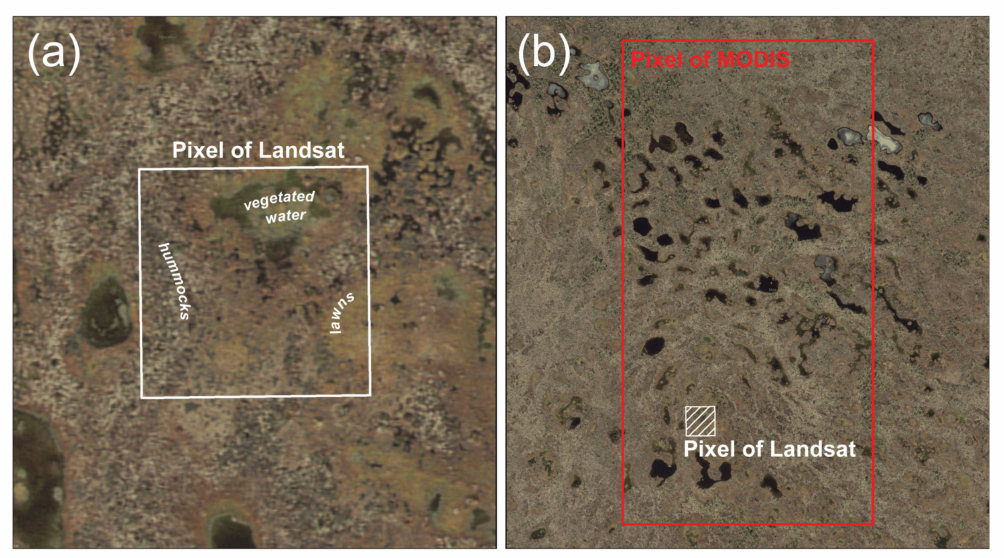
Figure 9. Comparison of the area represented by one Landsat pixel ( a ) and one MODIS pixel ( b ). The location of the Landsat_30m ‘best pixel’ in the EE_LIN site is